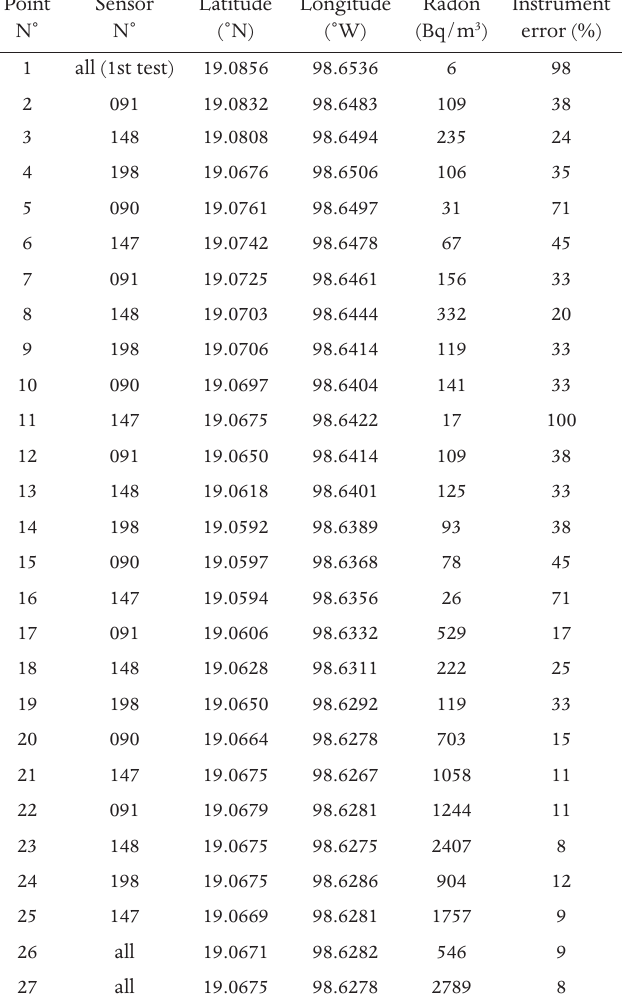
time).Point Table 2. Radon concentration results (40 min sampling